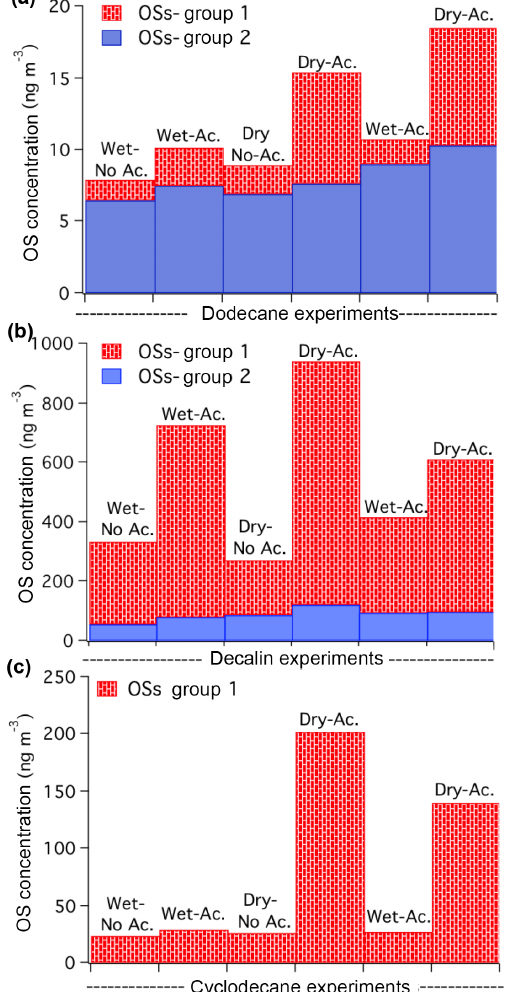
Figure 5. Impact of acidity on OS formation from gas-phase oxi- dation of (a) dodecane, (b) decalin and (c) cyclodecane. OSs from group 1 corresponds to compounds strongly impacted by aerosol acidity, while OSs from group 2 appeared to have less dependency on aerosol acidity.